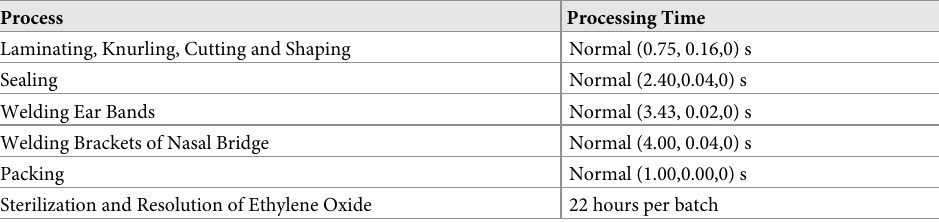
Table 2. Processing time of each